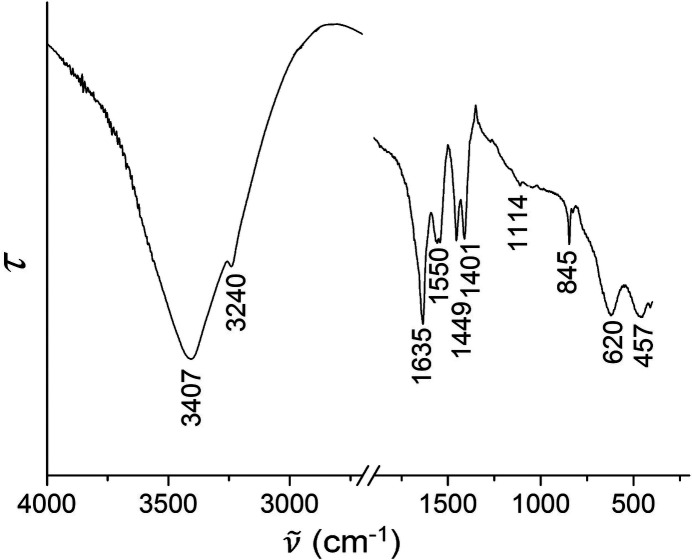
IR spectrum of MgCO3·MgCl2·7H2O under ambient conditions.